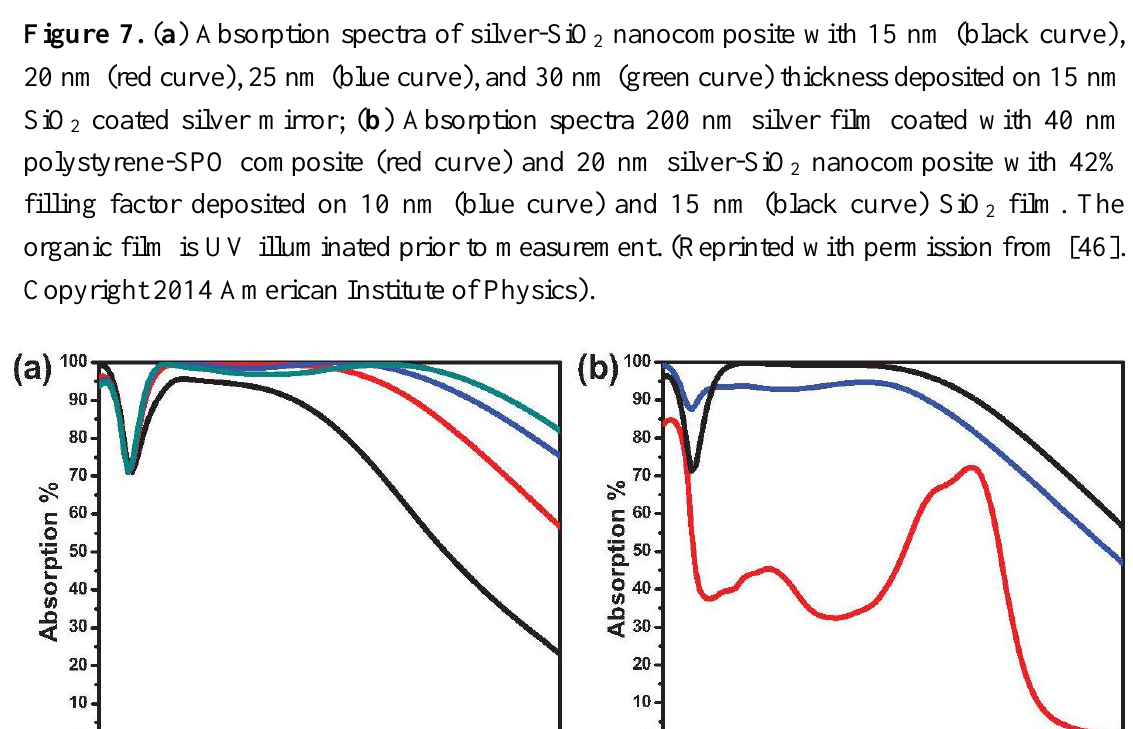
nanocomposite with 15 nm (black curve), 2 nanocomposite with 42% 2 film. The 2